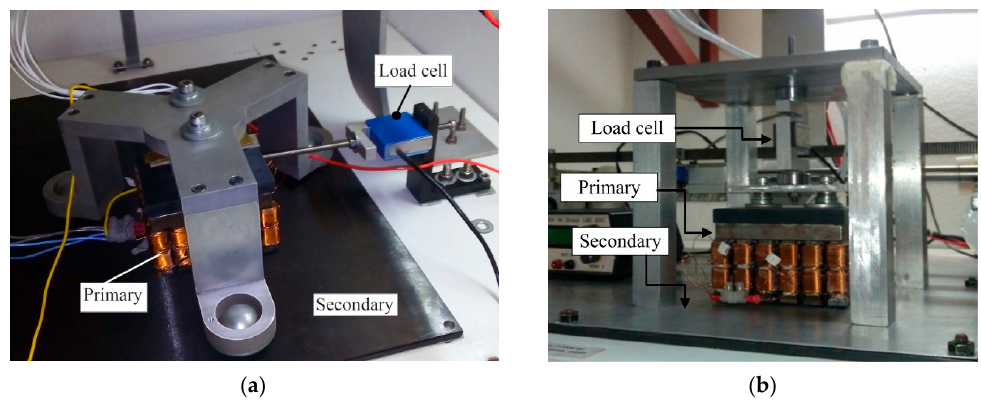
Figure 5. Experimental setup: ( a ) for thrust force measurement; ( b ) for normal force measurement.